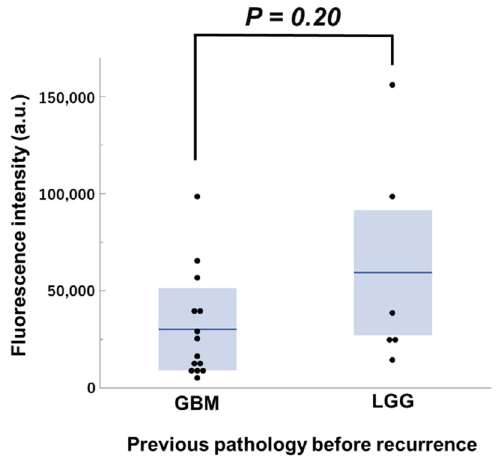
Figure 3. HE staining and fluorescence microscopy images of normal brain tissue surrounding the tumor ( A , B ) and recurrent glioblastoma in contrast-enhanced lesions ( C , D ). Samples were processed for H&E staining or immunofluorescence examination. The nuclei of the tumor cells were stained with DAPI, and red fluorescence at 640 nm was detected in the tumor cells at an excitation wavelength of 400 nm, which indicated the TS uptake in the tumor and normal brain tissue. Abbreviations: CE, contrast enhanced.